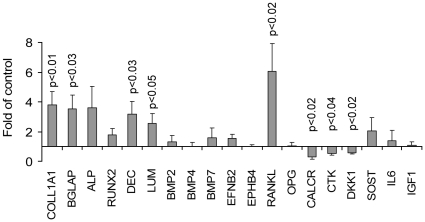
PTH treatment alters gene expression in whole myelomatous human bones engrafted with Hg myeloma cells.SCID-hu mice engrafted with Hg myeloma cells were treated with saline or PTH for 4 weeks. Mice were sacrificed 2 hours after the last injection, and RNA was extracted from the whole myelomatous human bone (five bones/group). RNA samples were subjected to global gene expression profiling (see partial list in Table 2 and complete list in Table S1 of differentially expressed genes). The same RNA samples were also used to validate and analyze expression of selected bone-associated genes by qRT-PCR as indicated in the figure.